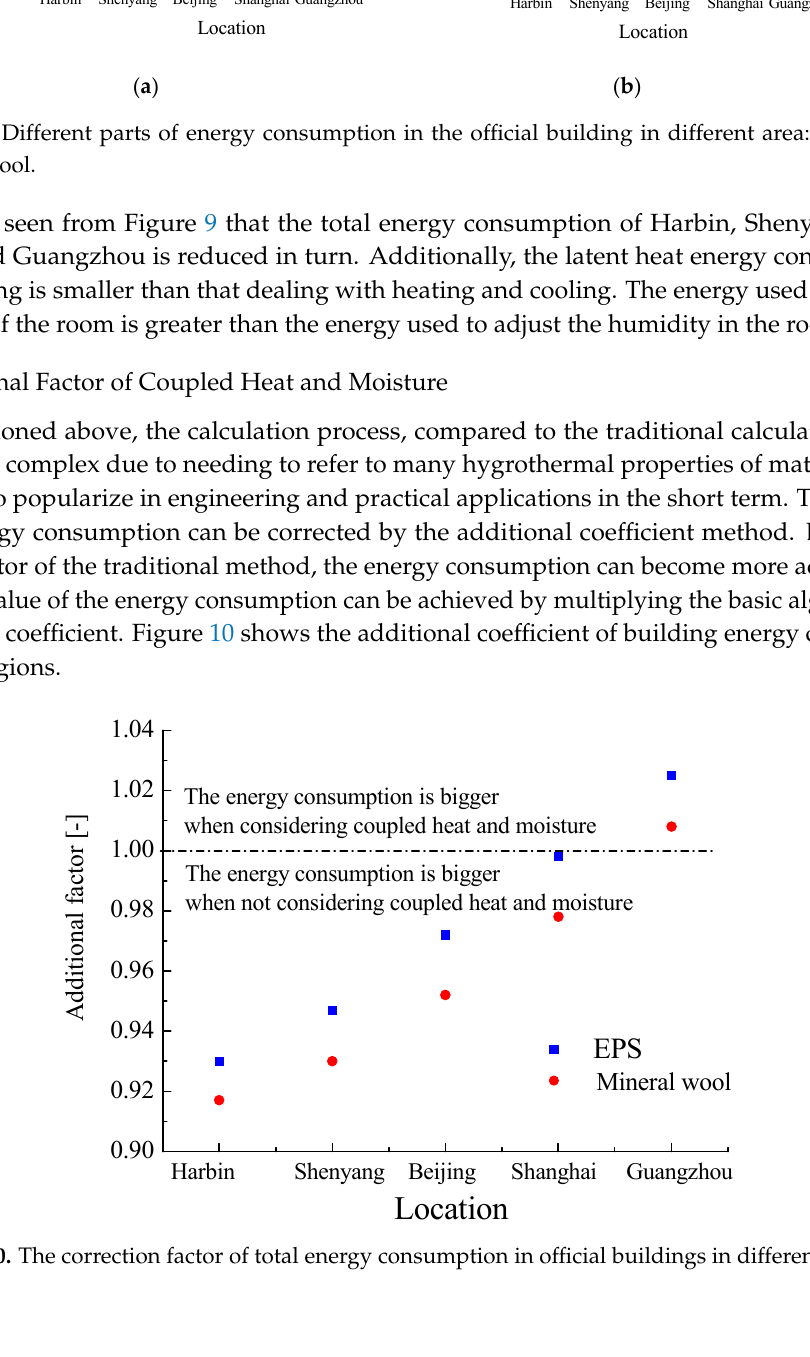
Figure 10. The correction factor of total energy consumption in official buildings in different areas.